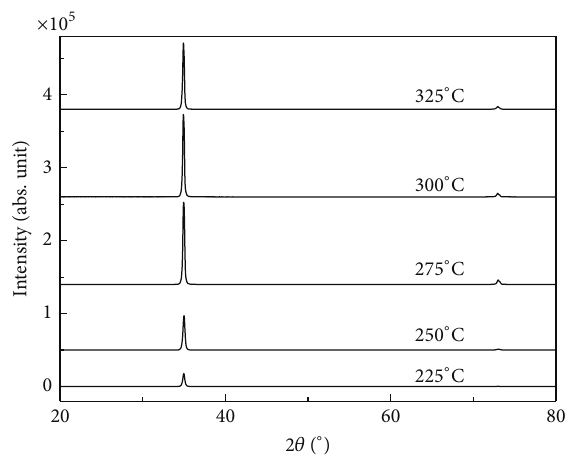
Figure 1: The XRD patterns for the AZO film deposited at a pressure of 2.7 × 10 −1 Pa.